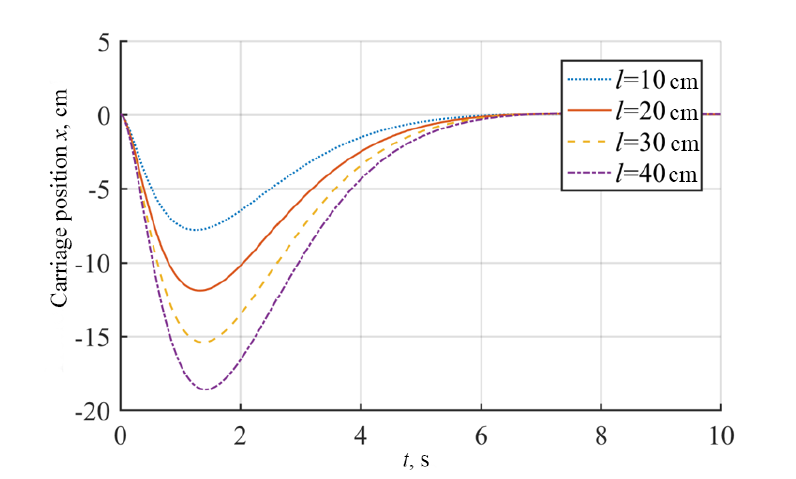
Figure 8. Carriage position x at different l .